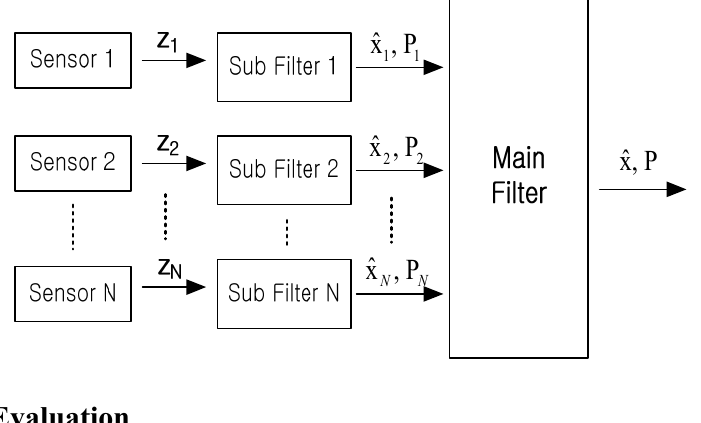
Figure 3. Proposed sensor fusion method with the IMM filter.